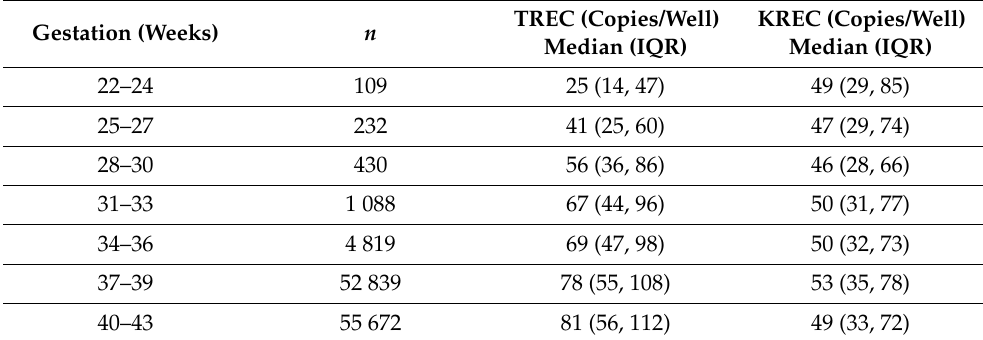
Table 1. Median TREC and KREC values in children of different gestational